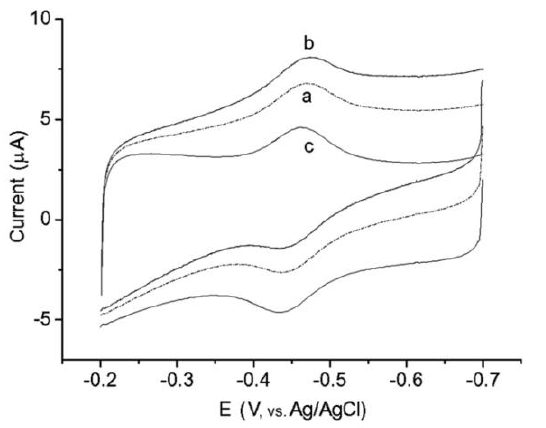
Figure 7. Cyclic voltammograms of a CYP2B6/Au–chitosan modified GCE in PBS (0.1 M, pH 7.4) that was air saturated (a), air saturated with the addition of 0.2 mM BUP (b), and nitrogen saturated (c). Scan rate: 100 mV/s. Reprinted from reference [45] with permission from Elsevier Science